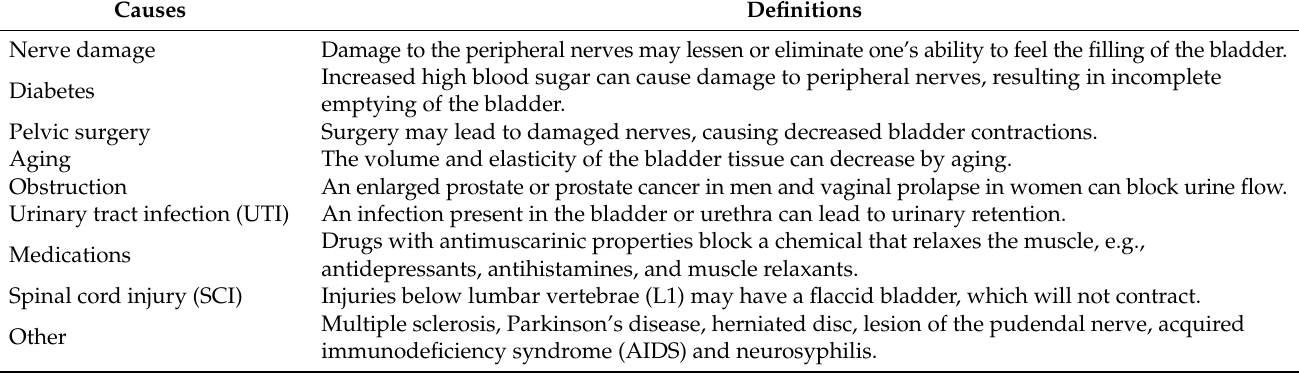
Table 4. Causes and definitions for UAB [30].